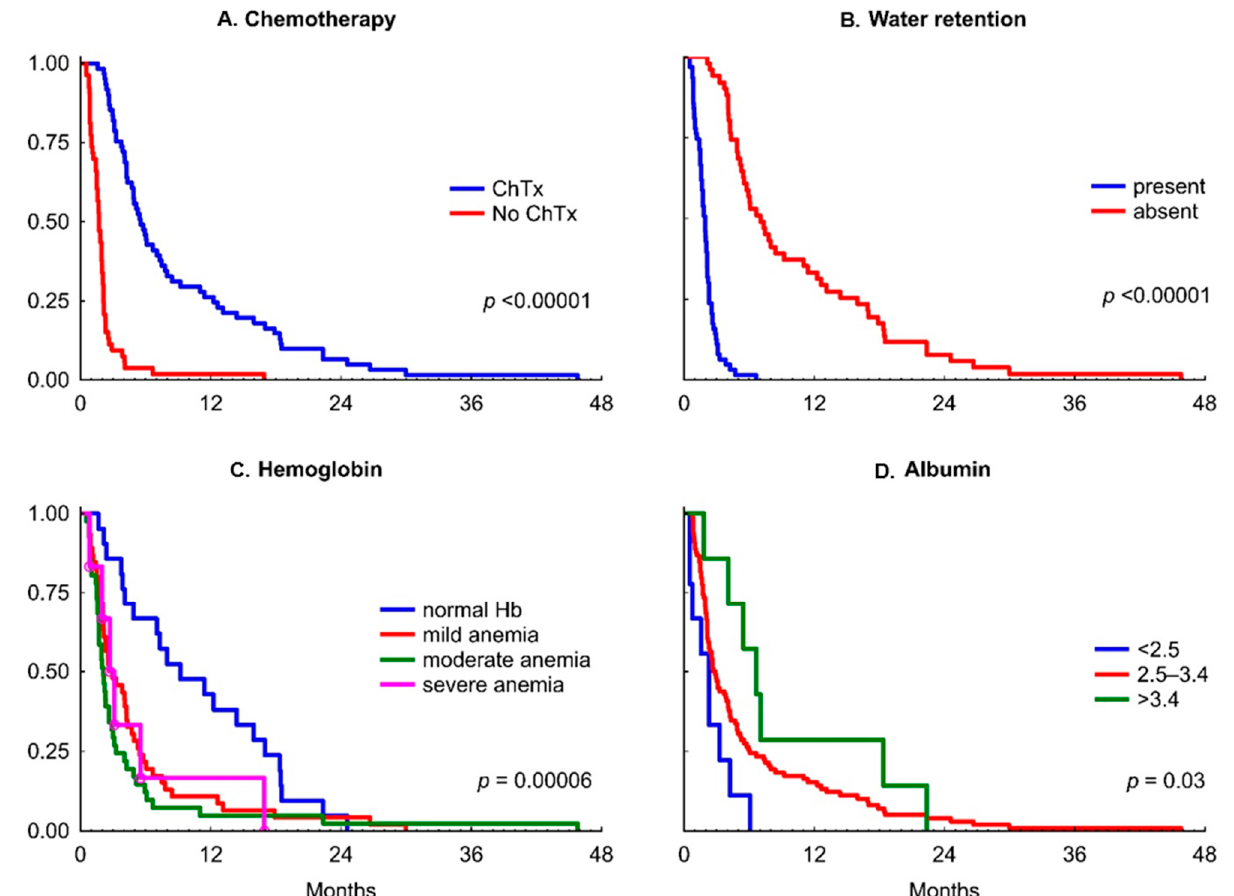
Figure 2. The Kaplan–Meier curves and initial clinical and laboratory values. ( A ) chemotherapy (ChTx) continued; ( B ) water retention; ( C ) hemoglobin; ( D ) serum albumin.